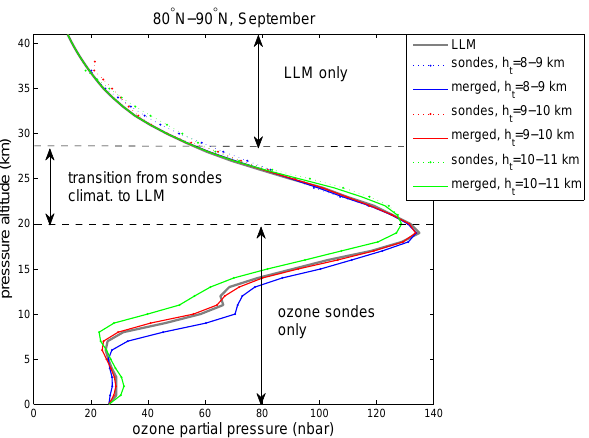
Fig. 5. Illustration of data merging when SAGE-II data are not avail- able. A smooth transition from the ozonesonde climatology to the LLM climatology is performed using the altitude interval 20–28km. In this and subsequent figures, ozone partial pressure is shown for a better visualization. Note that in TpO 3 climatology files, ozone mixing ratio is